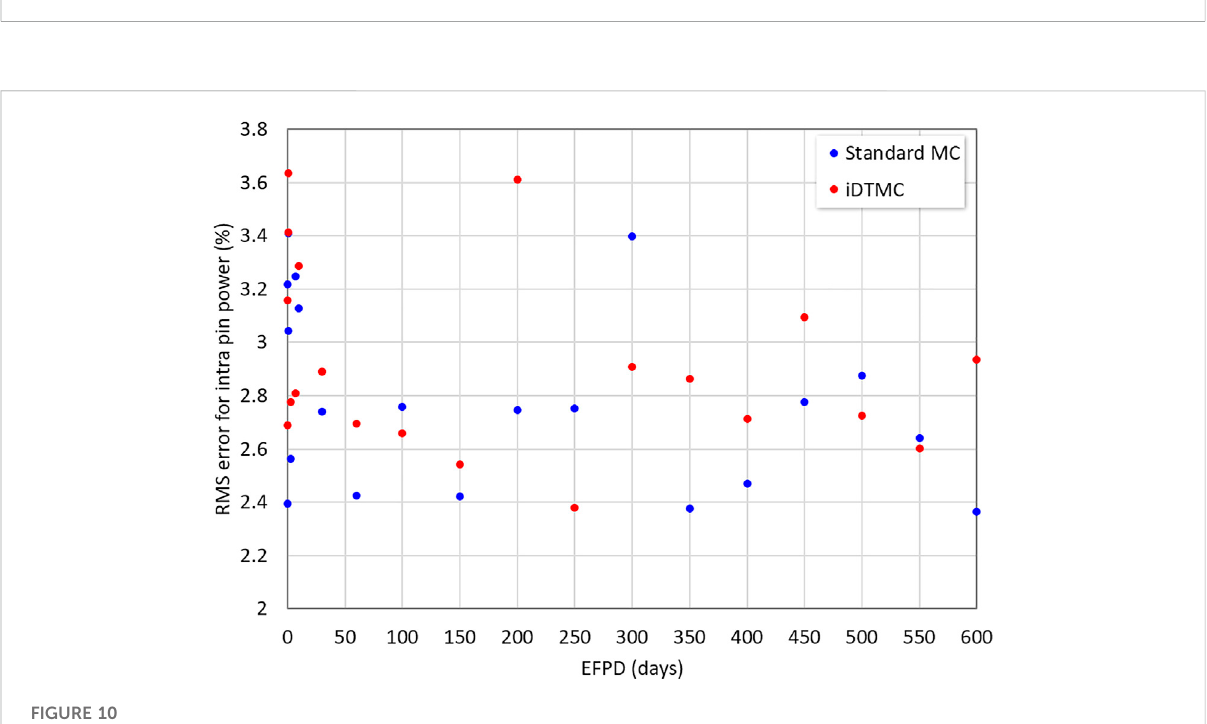
FIGURE 10 RMS errors for intra-pin power distribution (active cycle